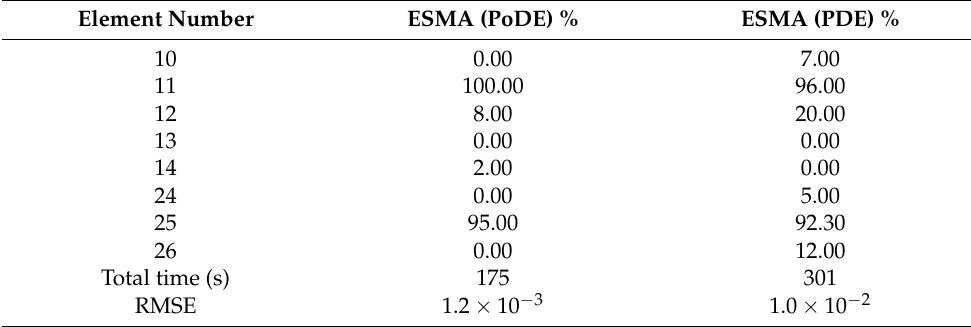
Table 6. PoDEs and PDEs of case 2 for the 31-bar planar